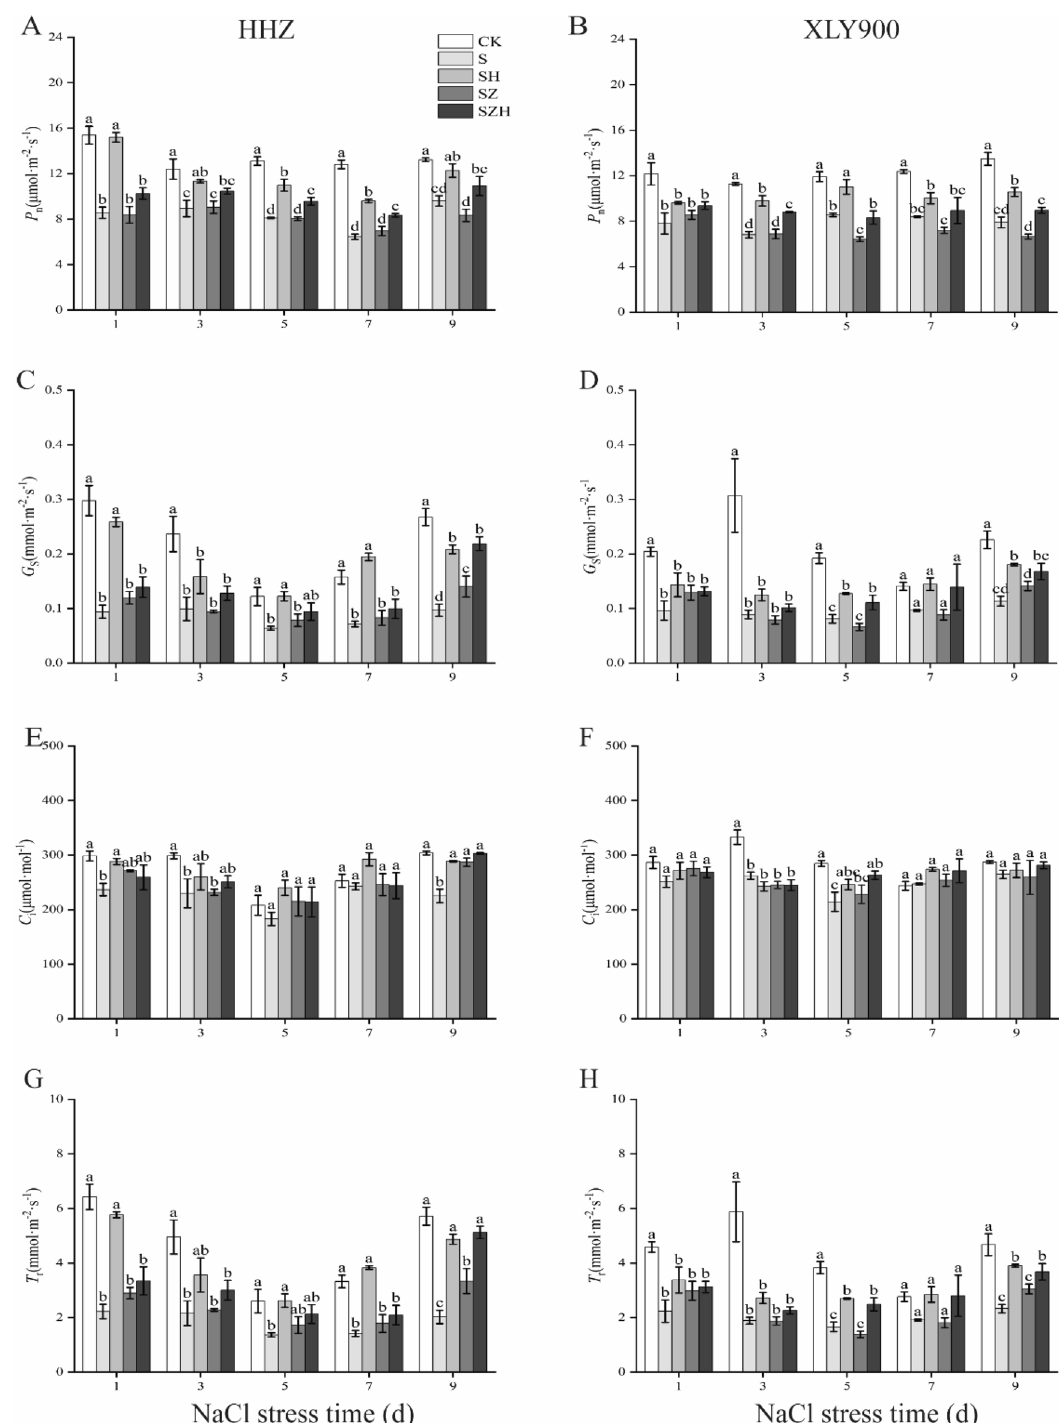
Figure 6. Effect of Hemin on gas exchange parameters in rice under salt stress. P n in HHZ ( A ) and XLY900 ( B ); G s in HHZ ( C ) and XLY900 ( D ); C i in HHZ ( E ) and XLY900 ( F ); and T r in HHZ ( G ) and XLY900 ( H ). CK: 0 mM NaCl + 0 μmol·L −1 Hemin, S: 50 mM NaCl + 0 μmol·L −1 Hemin, SH: 50 mM NaCl + 5 μmol·L −1 Hemin, the mean ± SD of three replicate samples. Different letters in the data column indicate significant differences (p < 0.05) according to Duncan’s